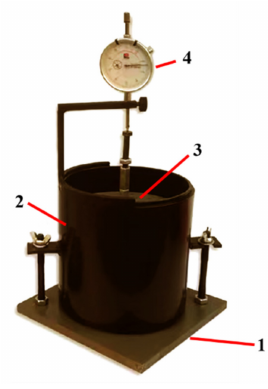
Figure 2. Steel slag volume expansion test setup. 1—Lower perforated plate; 2—steel slag; 3—surcharge board; 4—dial